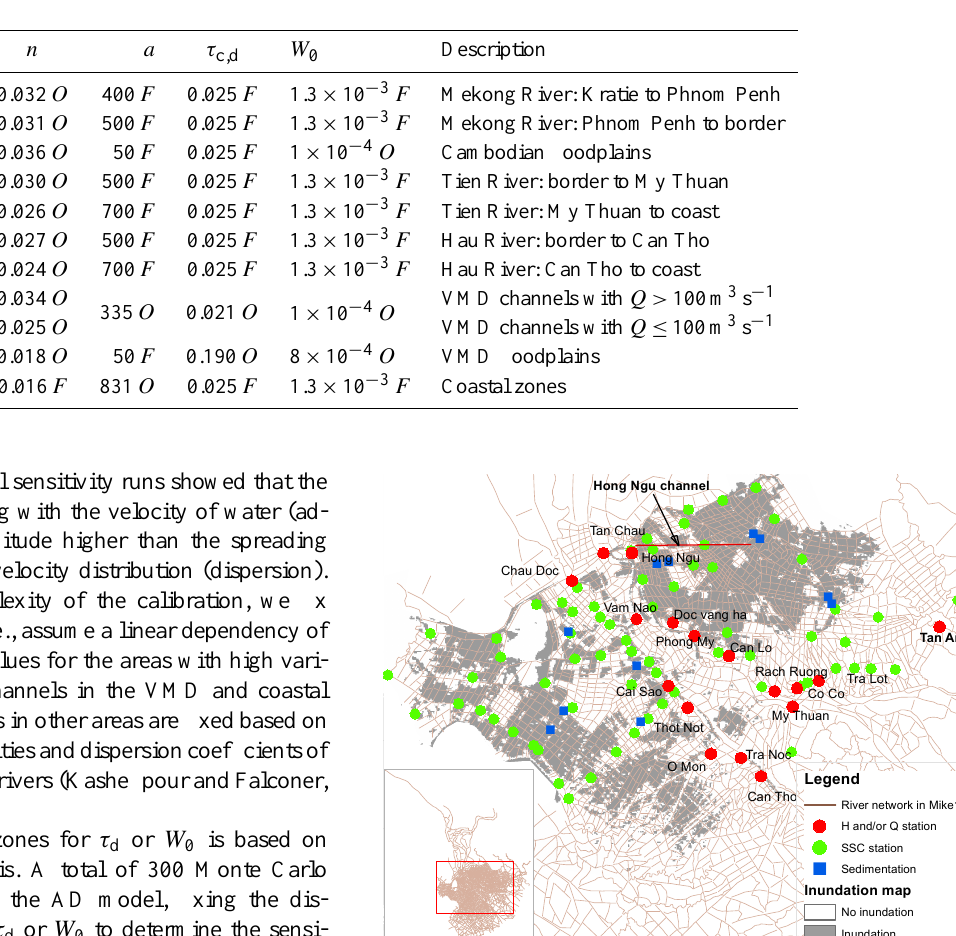
Table 1. Calibration parameters and calibration zones: Manning roughness coefficient ( n ), dispersion factor ( a ), critical deposition shear stress τ c,b (Nm − 2 ) and free settling velocity W 0 (ms − 1 ). Least Euclidian distance Pareto-optimal parameters ( O ) and fixed parameters ( F ).